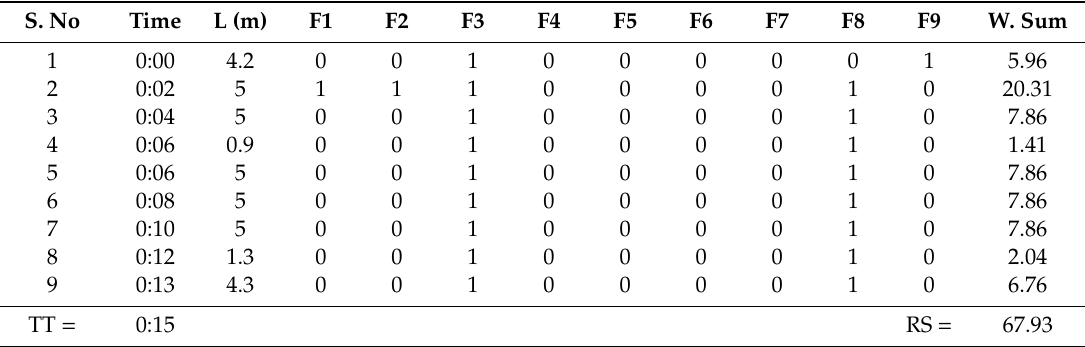
Table 6. RS calculation for Route 2 (without a second fire).